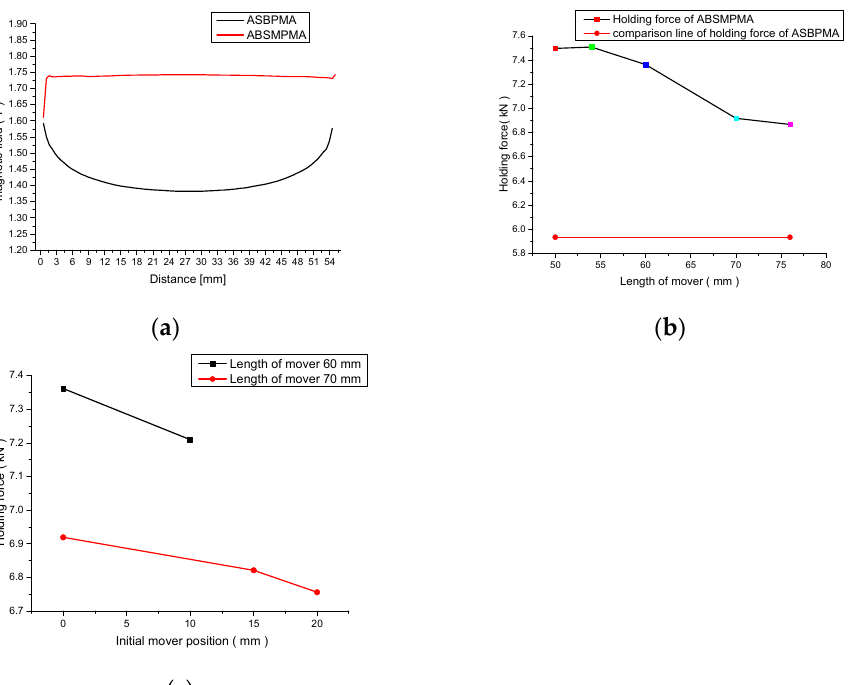
Figure 4. The results of 2-D FE are shown. ( a ) The magnetic field in gap. ( b ) The characteristic of the mover length vs. retaining force. ( c ) The influences of the initial mover position for retaining force.